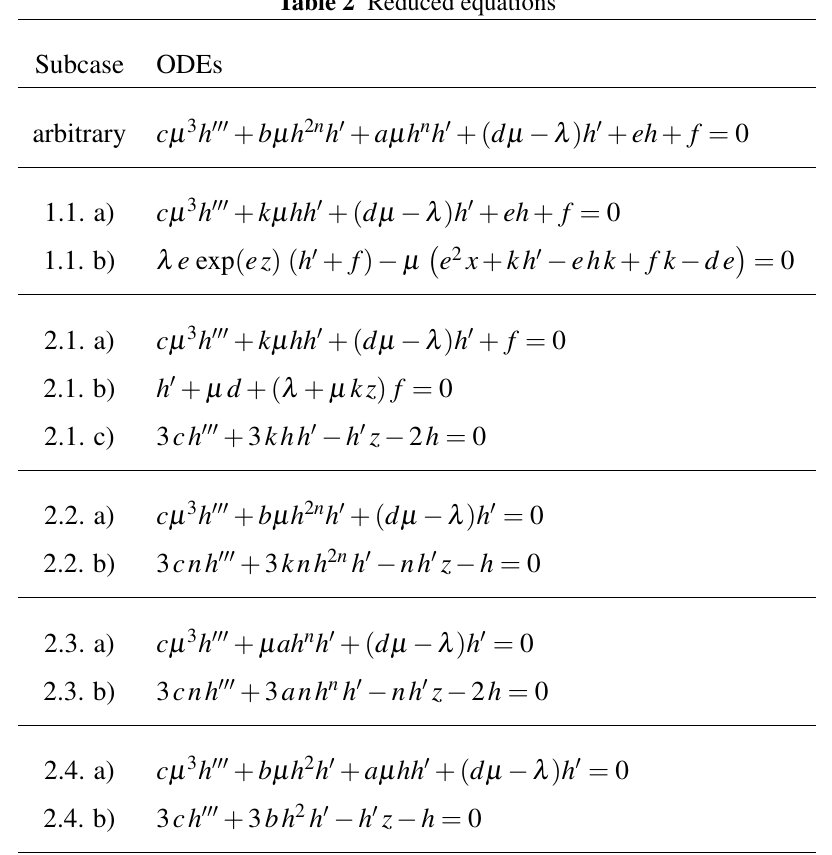
Table 2 Reduced